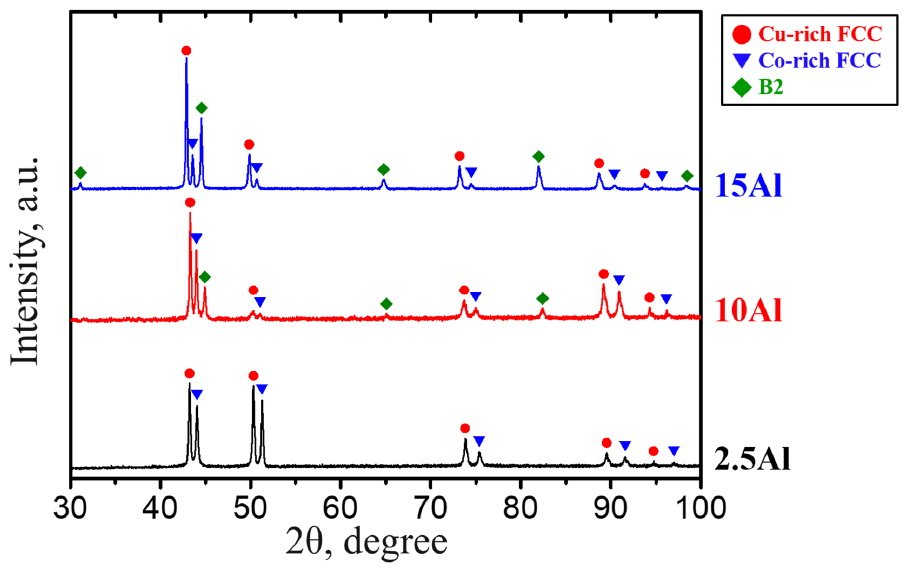
Figure 2. X-ray diffraction (XRD) patterns of the present